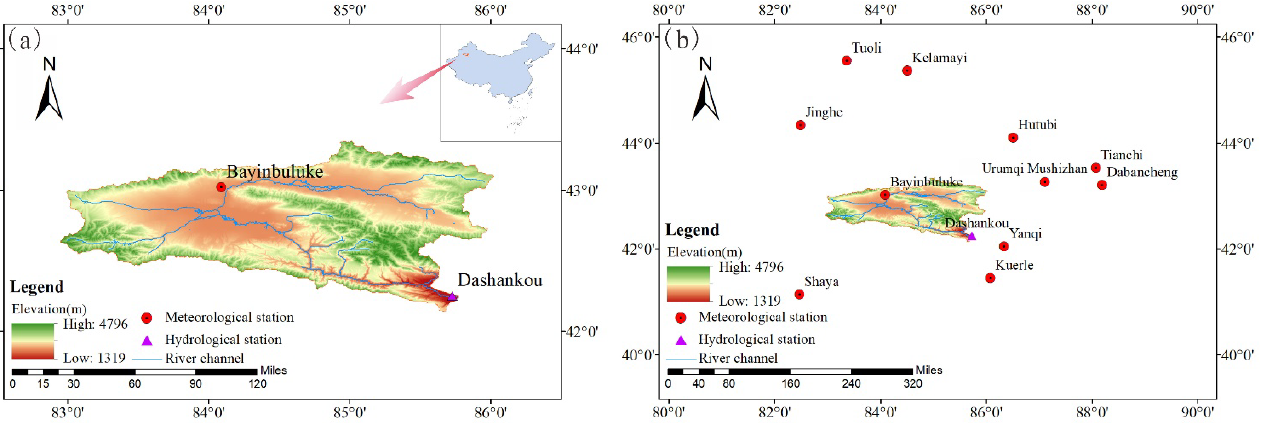
Figure 1. The topography and river network in the upper reaches of the Kaidu River basin ( a ); the stations in and around the basin ( b ).